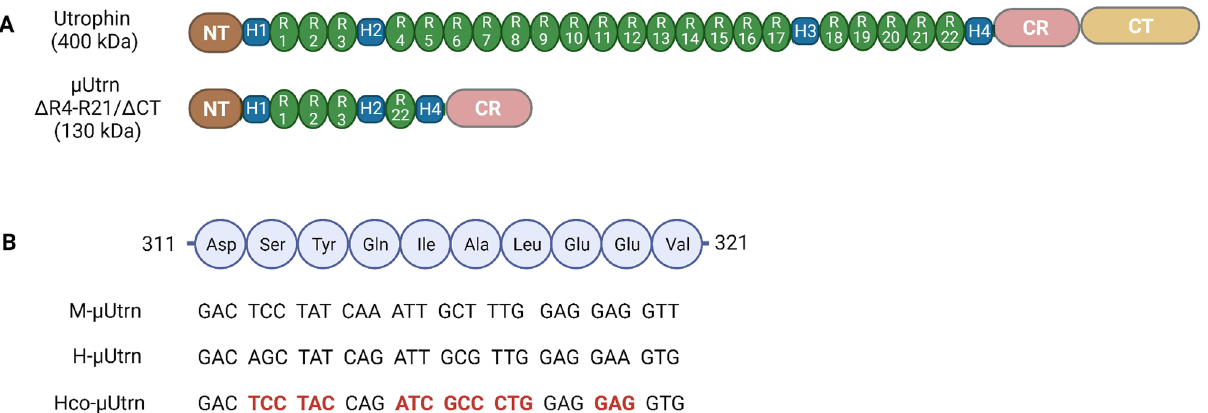
Figure 1. Design of µUtrn-coding sequences. ( A ) Domain structure of full-length utrophin and µUtrn proteins. Domain configuration of µUtrn ∆R4-R21/ΔCT closely resembles microdystrophin R4-R23/ΔCT and consists of an N-terminal actin-binding domain, hinge 1, spectrin-like repeats 1–3, hinge 2, spectrin-like repeat 22, hinge 4, and a cysteine-rich (CR) domain. ( B ) Alignment of the µUtrn coding sequences used in this study. Fragments of spectrin-like repeat 1 coding sequences are shown for mouse ( M- µ Utrn ), human ( H- µ Utrn ), and codon- optimized human ( Hco- µ Utrn ) µUtrns. Codons optimized for expression in muscle are highlighted in bold